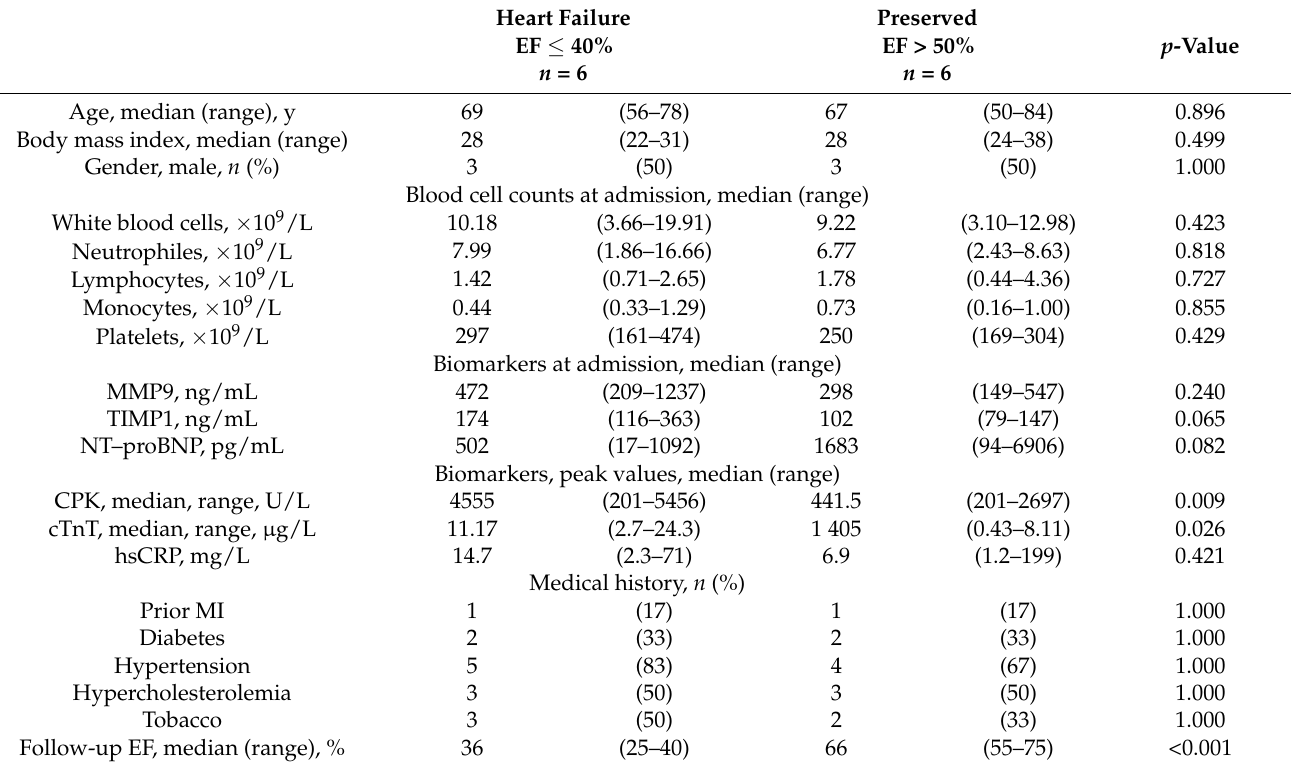
Table 1. Demographic and clinical characteristics of two groups of MI patients used for blood M6A quantification. p -values for two-group comparisons are